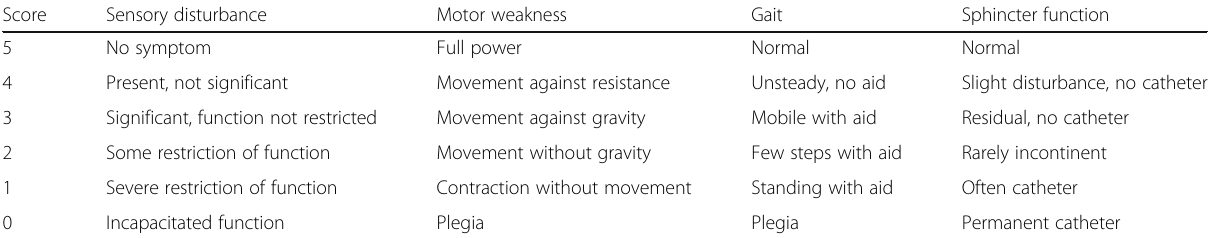
Table 1 Neurological scoring system for neurological deficit assessment (Klekamp et al.